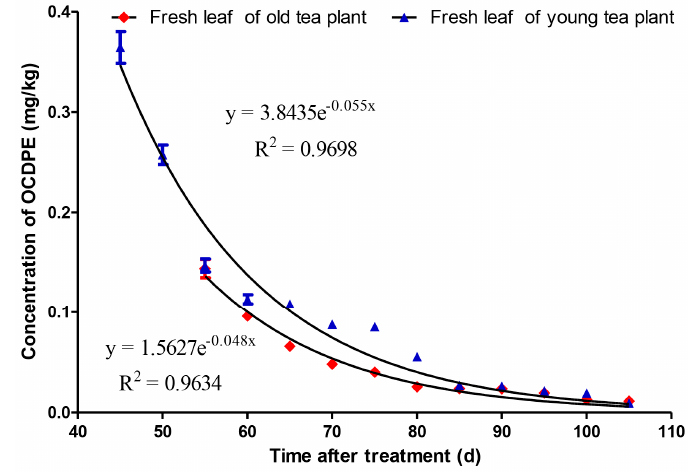
Figure 4. The dissipation curve of OCDPE in the fresh leaves of young and old tea plants (n = 3).